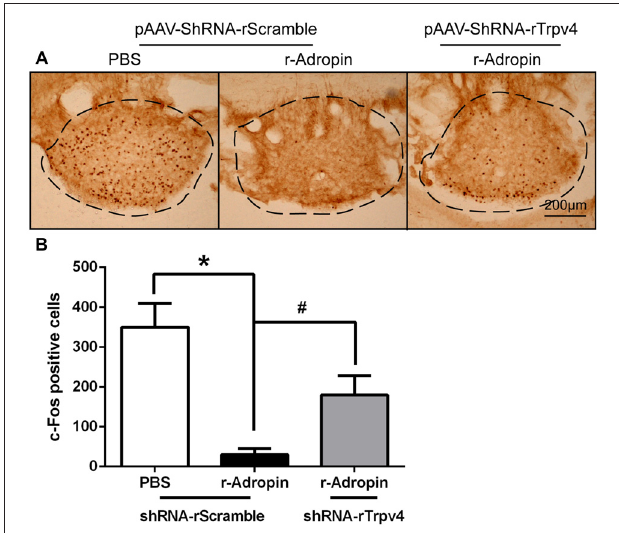
FIGURE 4 | Central administration of recombinant adropin reduced c-Fos positive cells via TRPV4 signaling under normoxic condition in SFO. (A) c-Fos positive cells (visualized as brown staining) in SFO decreased 1 h after central administration of 3 nM recombinant adropin in overnight water deprivation-induced drinking in rats. The adropin-induced c-Fos reduction was reversed by TRPV4 shRNA, Scale bar, 200 µ m. (B) Quantification of c-Fos positive cells (three rats for each group; ∗ P < 0.05, # P <